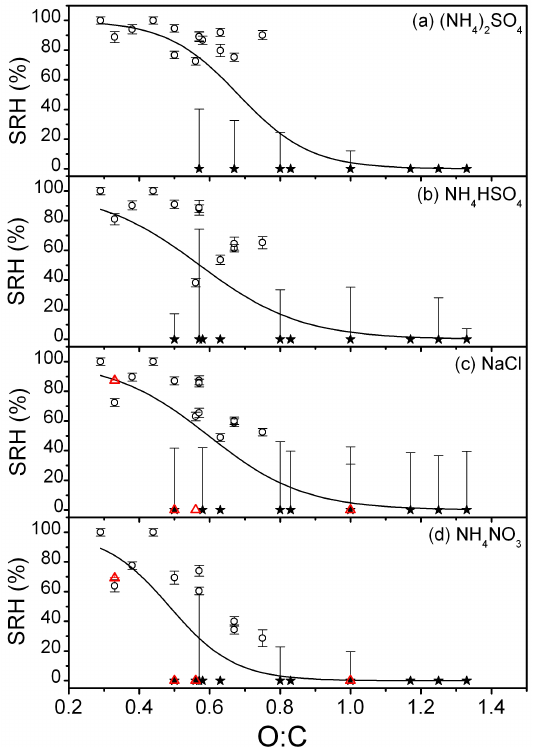
Fig. 3. Summary of SRH results (OIR = 2.0 ± 0.1) as a function of oxygen-to-carbon elemental ratio (O:C): (a) organic-ammonium sulfate particles, (b) organic-ammonium bisulfate particles, (c) organic-sodium chloride particles and (d) organic-ammonium ni- trate particles. Circles represent the relative humidity at which sep- aration occurred. Error bars associated with the circles represent 2 σ of multiple SRH measurements and the uncertainty from the cali- bration. Stars indicate that liquid–liquid phase separation was not observed. The error bars corresponding to the stars indicate that liquid–liquid phase separation could potentially occur within the range indicated by the error bars, but could not be detected due to the occurrence of efflorescence in the particles. The curves in the panels are Sigmoidal–Boltzmann fits to the data. Red triangles rep- resent the results of liquid–liquid phase separation in bulk solution from Marcolli and Krieger 2006).